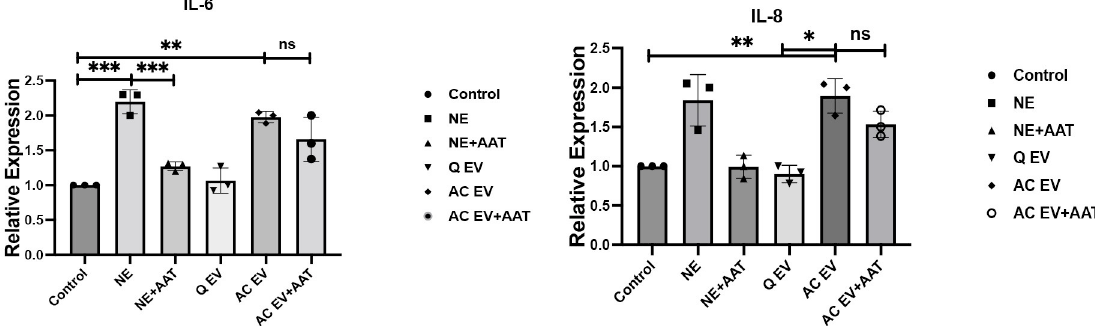
Fig 6. Unchecked activity of exosome associated neutrophil elastase (NE) activates lung endothelial cells in vitro. RNA expression levels of different pro-inflammatory cytokines in the MVECs analyzed 8 hours post treatment with purified NE, quiescent exosomes, and activated exosomes with or without purified AAT using qPCR, � p < 0.05, �� p < 0.005, ��� p < 0.0005 (two-tailed student’s